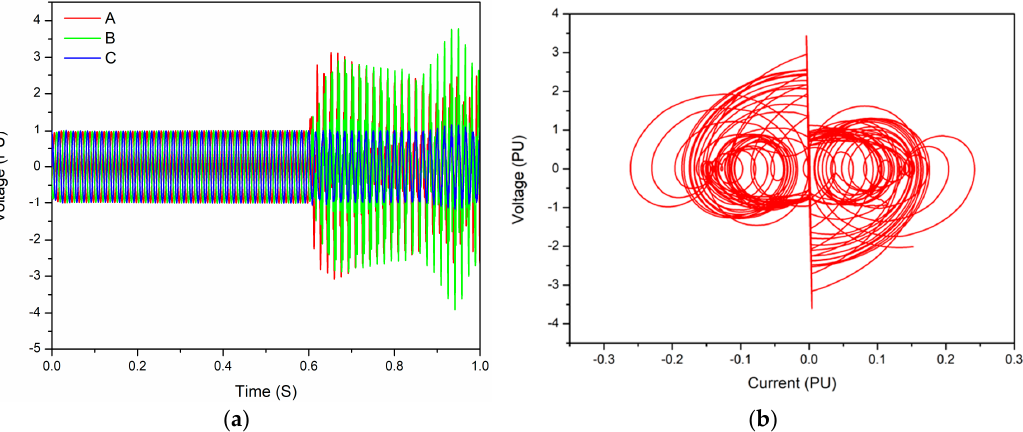
Figure 11. The ferroresonant results during de-energization at 0.6 secs on the WRIG wind turbine: ( a ) Voltage waveform of phase A, B and C with highest overvoltage on phase B; ( b ) Phase plane diagram of phase